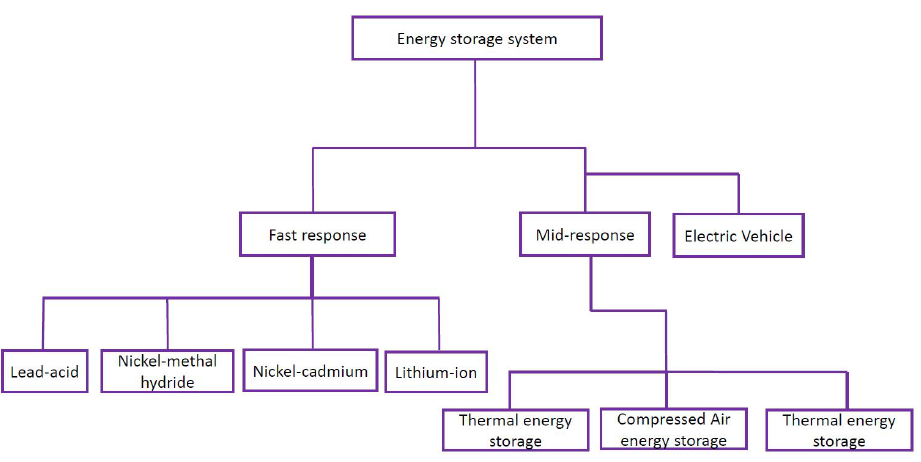
Figure 4. Flexibility response of energy storage